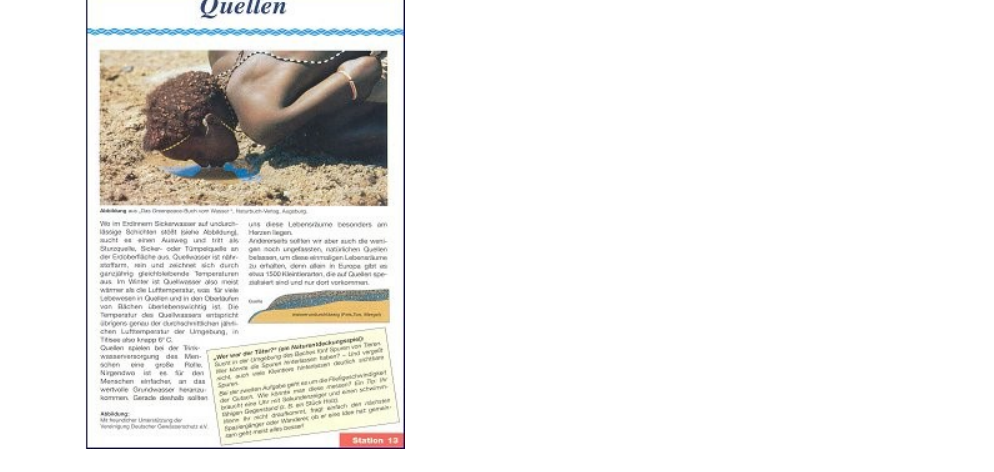
Figure 9. Panel without any regional reference (Titisee-Neustadt, Germany) (Megerle